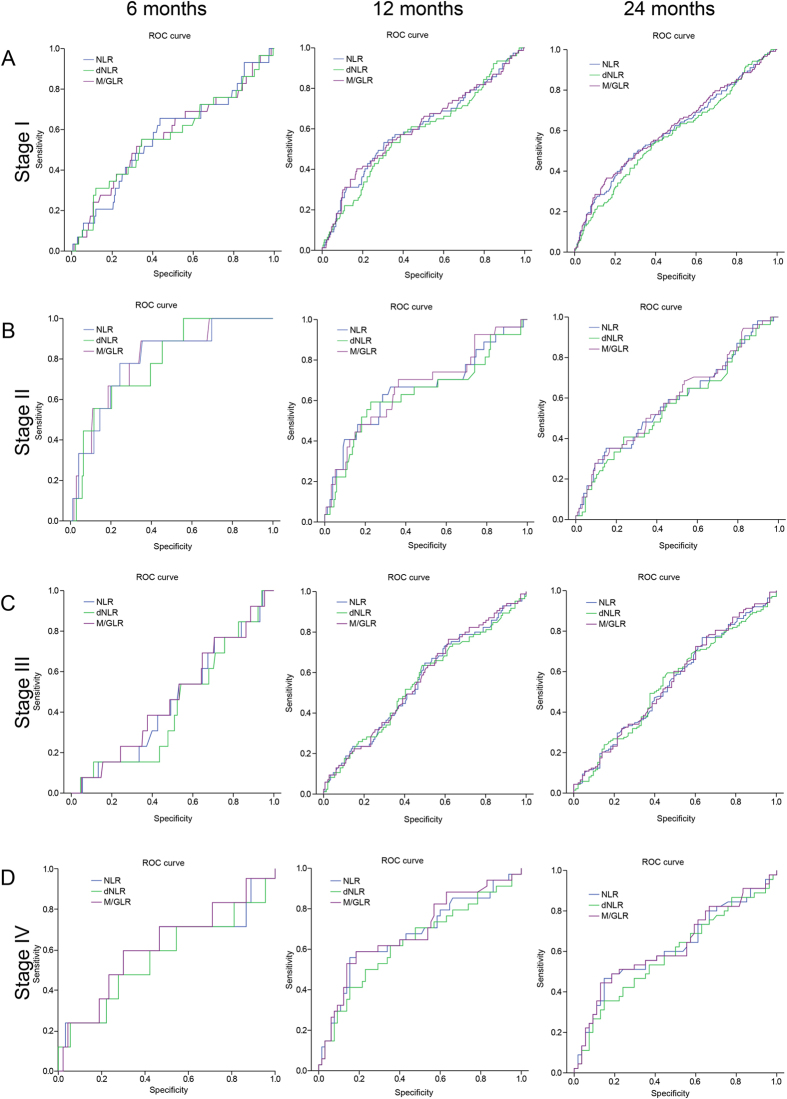
Comparison of the AUC for outcome prediction among NLR, dNLR, and M/GLR for patients with different TNM stages.(A) TNM-I, (B) TNM-II, (C) TNM-III, (D) TNM-IV.